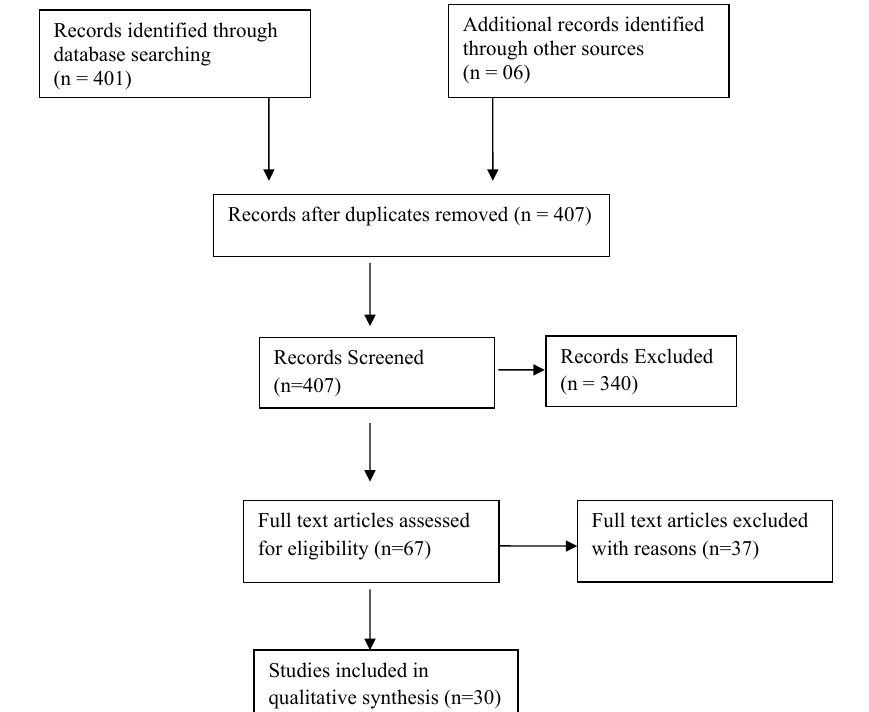
Figure 1. PRISMA flow chart showing the selection of articles for